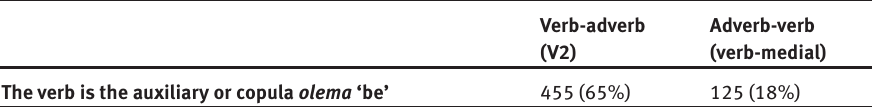
Table 4. The proportion of the verb olema ‘be’ in the datasets